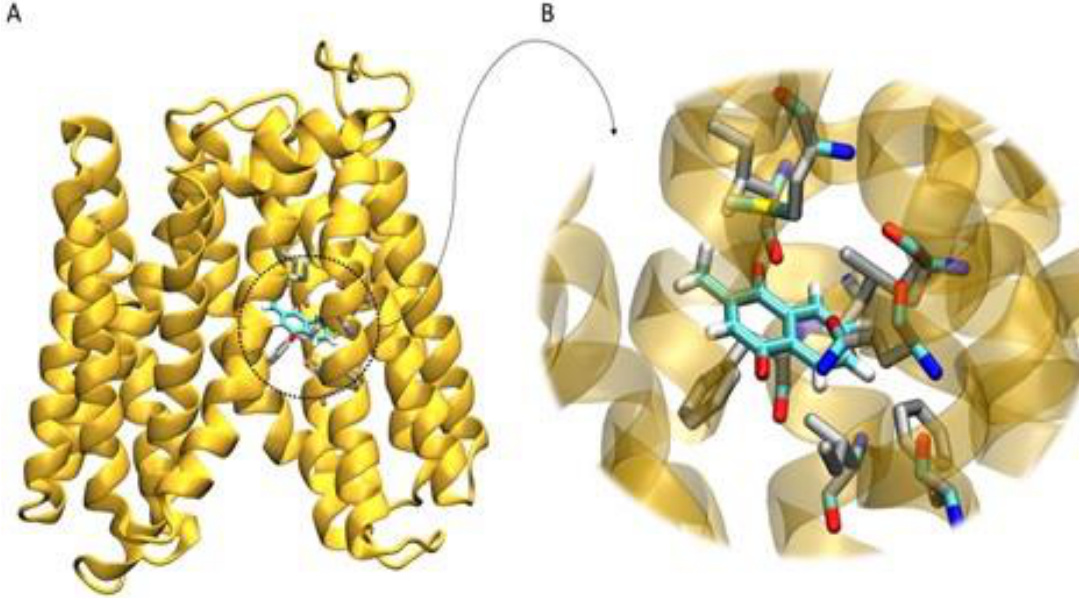
Figure 3. Molecular docking of the structural model for the complex menadione-nora. ( A ) Overall structure of NorA obtained through homology modeling, with the position of Menadione inside of the transmembrane channel. ( B ) Detail of the lowest energy conformation and most populated conformational cluster obtained from the molecular docking calculations. Menadione is interacting with the closer residues ILE12, ILE15, PHE16, ILE19, PHE47, GLN51, ALA105, and MET109. Ligand is represented in cyan. Receptor molecule is represented in yellow, while the residues closest to the ligand are represented in gray. Hydrogen, oxygen, nitrogen and sulfur are represented in white, red, blue and yellow, respectively.